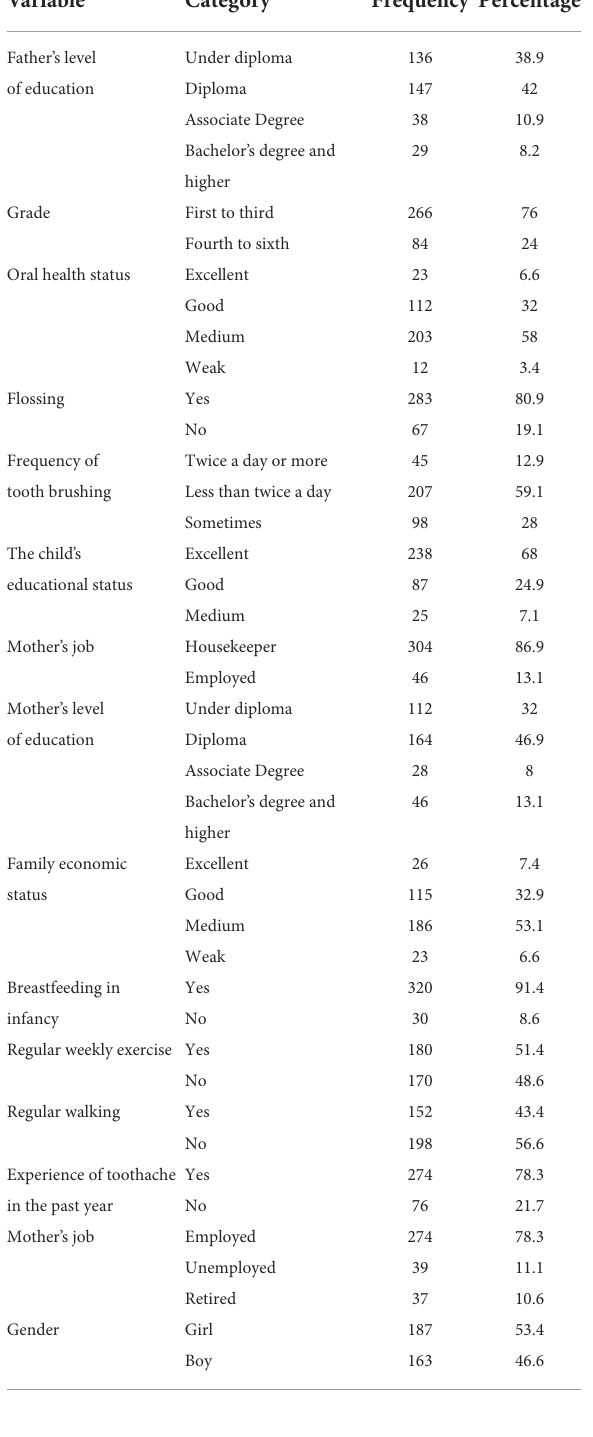
TABLE 1 Frequency distribution of students in terms of demographic variables.